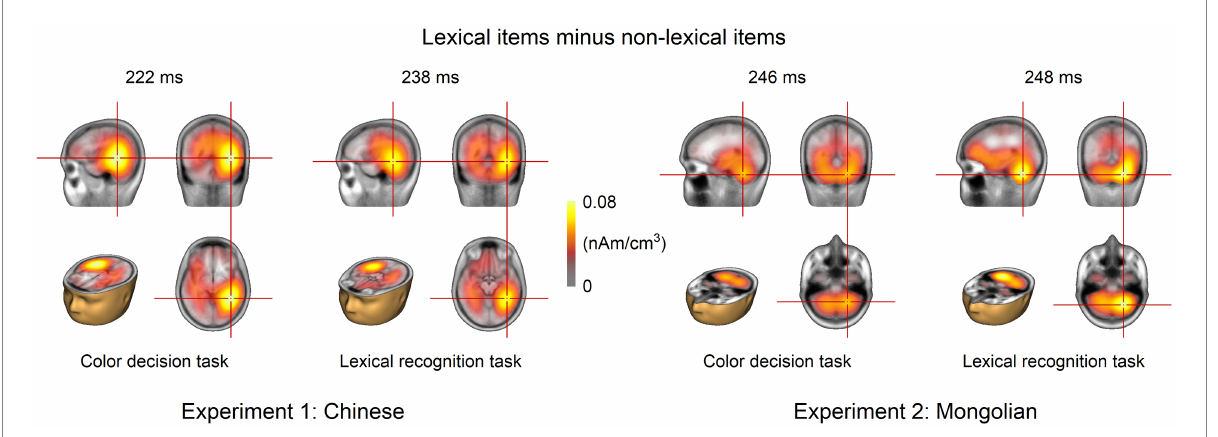
FIGURE 7 Source analysis results. Source analysis was performed at the GFP peak of the grand-averaged ERPs for each task and each experiment. The left and right ventral occipitotemporal cortices were the potential neural origins for both tasks and both